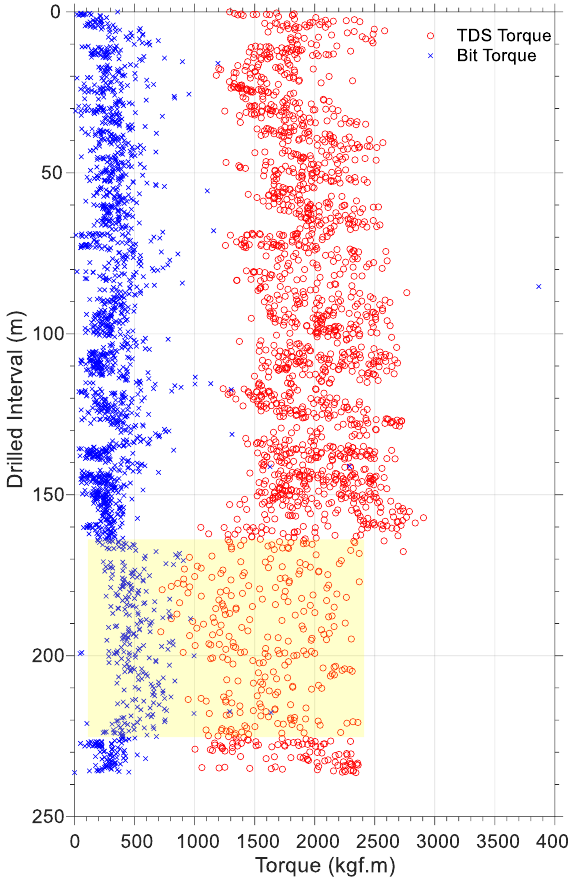
Figure 22. Torque at bit and toque delivered to the drill string at the surface for bit run number